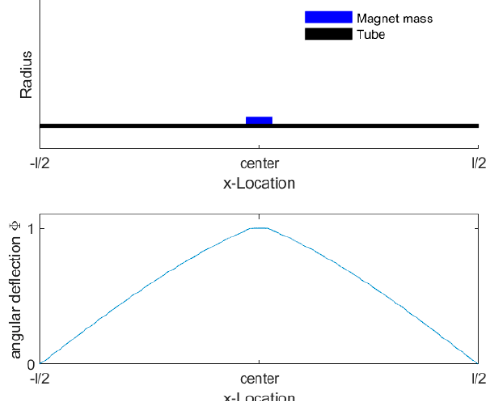
Figure 4. ( top ) Schematic cross-section of the tubular sensor, including the tube and magnet mass; ( bottom ) normalized solution of the excited torsional mode over measurement length ±l/2 .